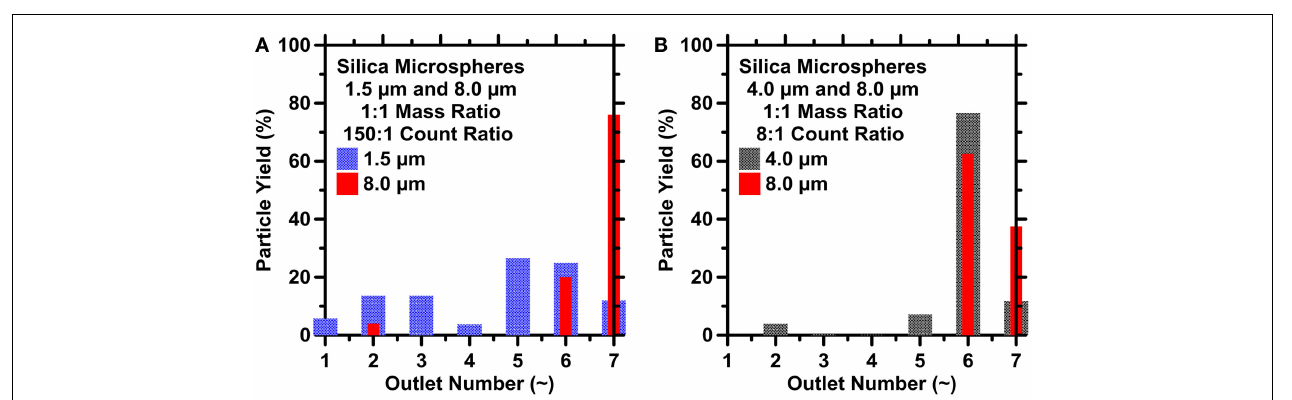
FIGURE 6 | The particle yield at different outlets for suspensions prepared using 1:1 mass ratio mixtures of: (A) 1.5 and 8.0 µ m and (B) 4.0 and 8.0 µ m silica microspheres . The highest uncertainty in the particle count, and hence particle yield based on ICA on replicate images is on the order of 9.8% for (A) and 11% for (B) ,